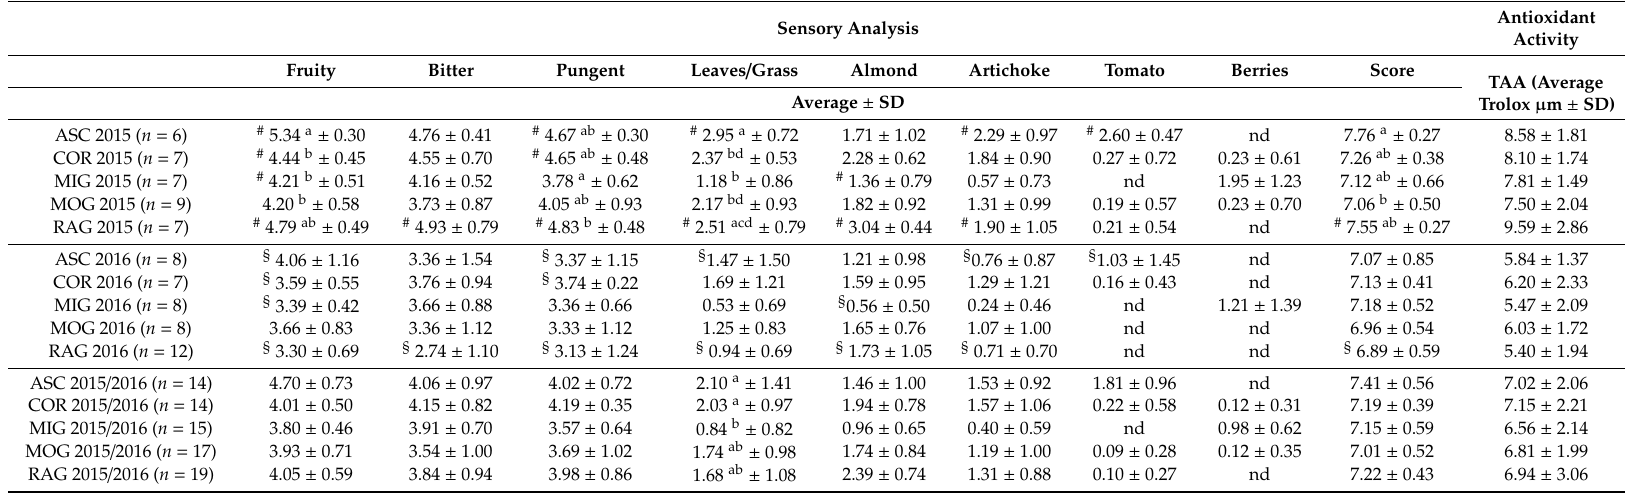
Table 3. Results from sensory analysis (average score of each sensory attribute and average overall score) and from antioxidant activity assay (total antioxidant activity (TAA) in terms of trolox ( µ M) ± standard deviation (SD) in the investigated monovarietal oils (ASC: Ascolana tenera, COR: Coroncina, MIG: Mignola, MOG: Piantone di Mogliano, RAG: Raggia) produced in 2015 and in 2016, and in the total 2015 / 2016 samples. Antioxidant Sensory Analysis Activity Fruity Bitter Pungent Leaves / Grass Almond Artichoke Tomato